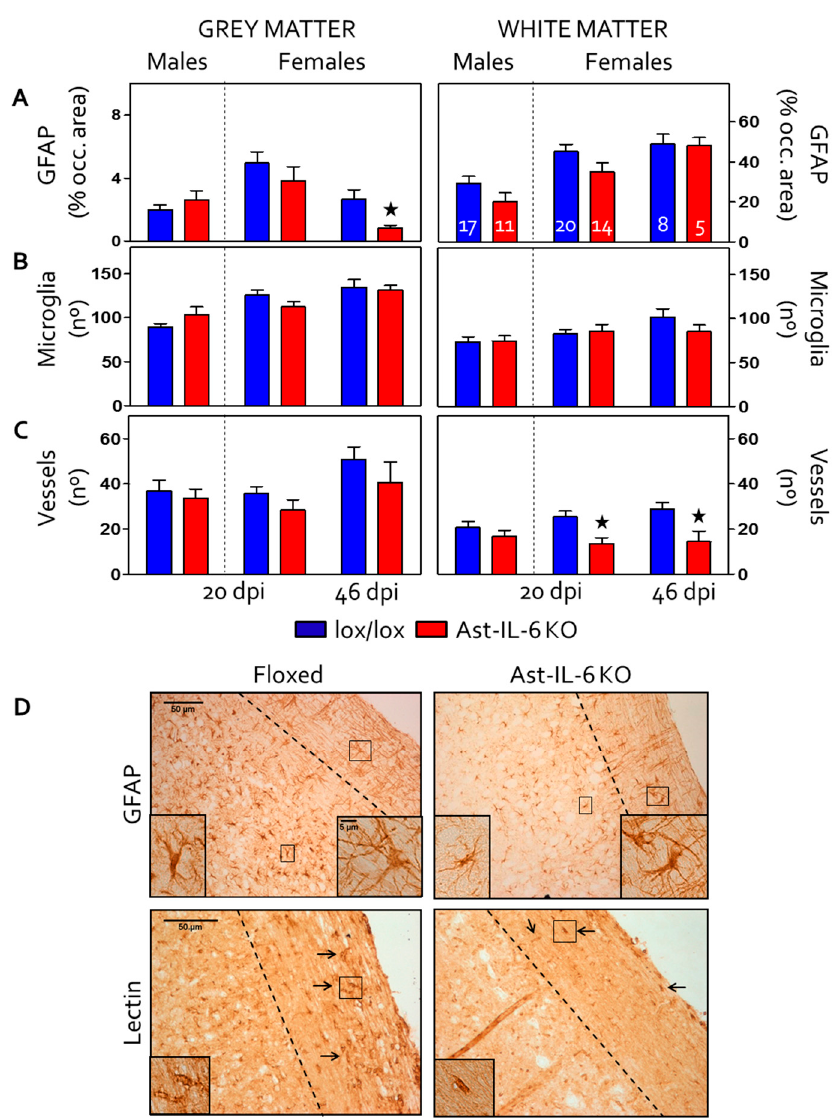
Figure 3. ( A – C ) Results from GFAP and lectin stainings in the spinal cord (grey and white matter) of EAE-induced animals at 20 dpi (for both females and males Ast-IL6 KO and floxed mice) and 46 dpi (females). Number of mice per group as indicated. GFAP overall immunostaining ( A ) and the number of lectin-positive microglia ( B ) and vessels ( C ) are shown. ★ p < 0.05 vs. floxed mice. ( D ) Representative GFAP at 100× (top) and lectin at 150× (bottom) stainings of 46 and 20 dpi females, respectively. Arrows indicate vessels. The discontinuous line separates grey matter (left) from white matter (right). All inserts are at 400×; at the top they, show astrocytic morphology in both grey and white matter, and at the bottom, they show a vessel.